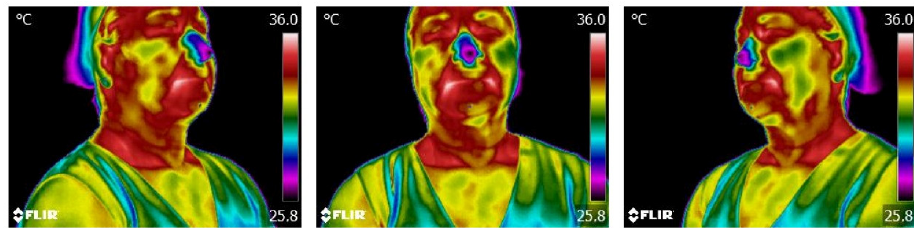
Figure 6. Thermal visualization representation in FLIR Tools ® at three different angles.